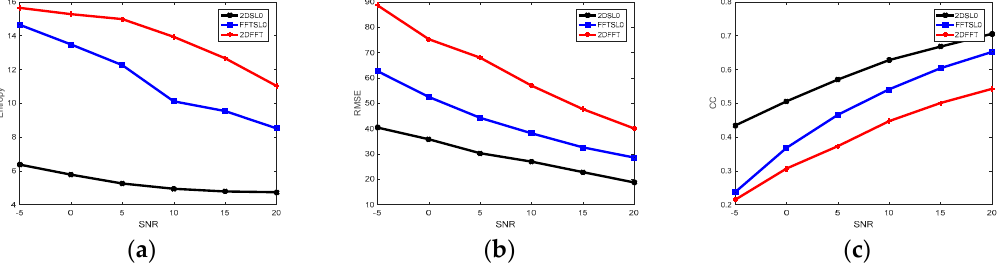
Figure 8. Curves of imaging performance under different SNRs. ( a ) Entropy versus SNRs, ( b ) RMSE versus SNRs, and ( c ) CC versus SNRs. Sensors 2018 , 18 , x FOR PEER REVIEW